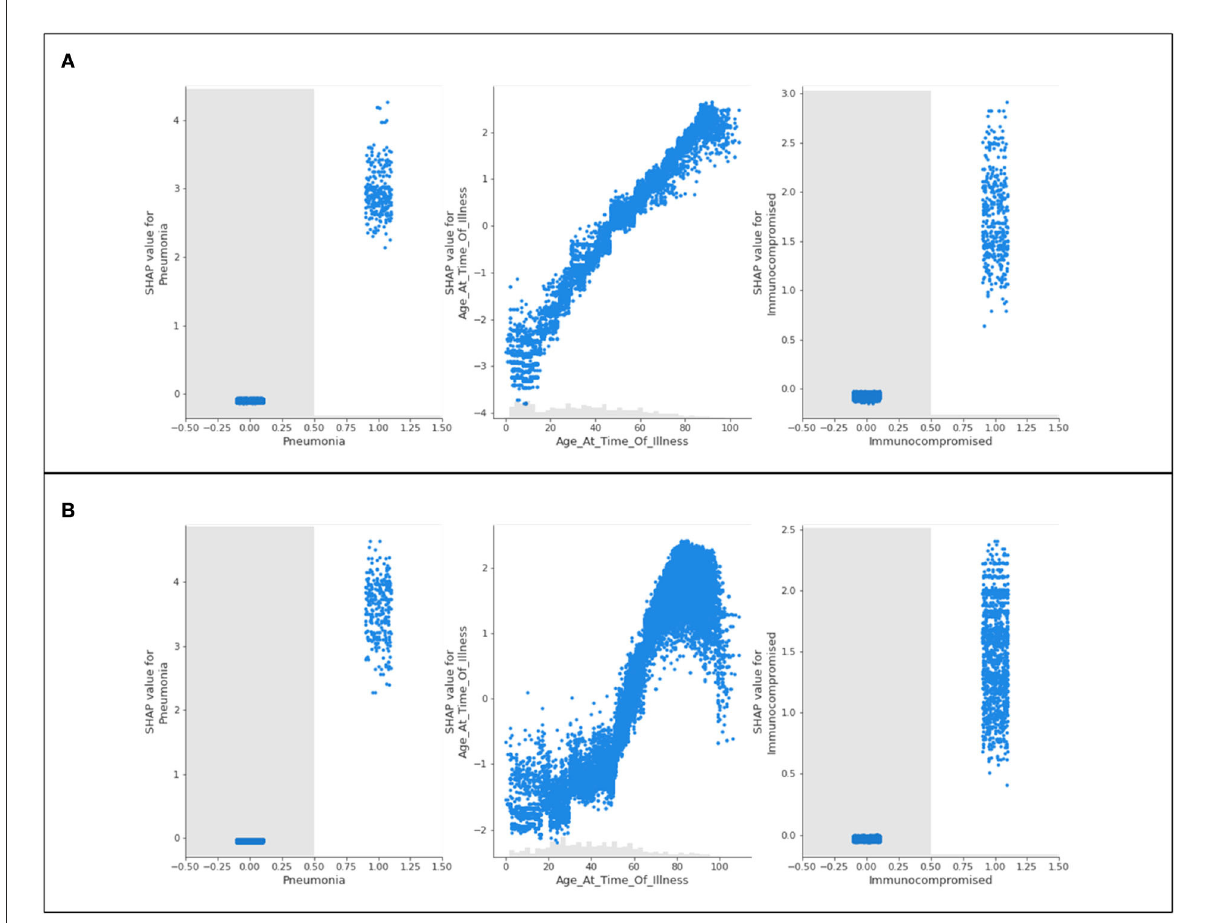
FIGURE3 Scatter plots of three features of concern (pneumonia, age, and immunocompromised) for (A) Delta- and (B) Omicron- related